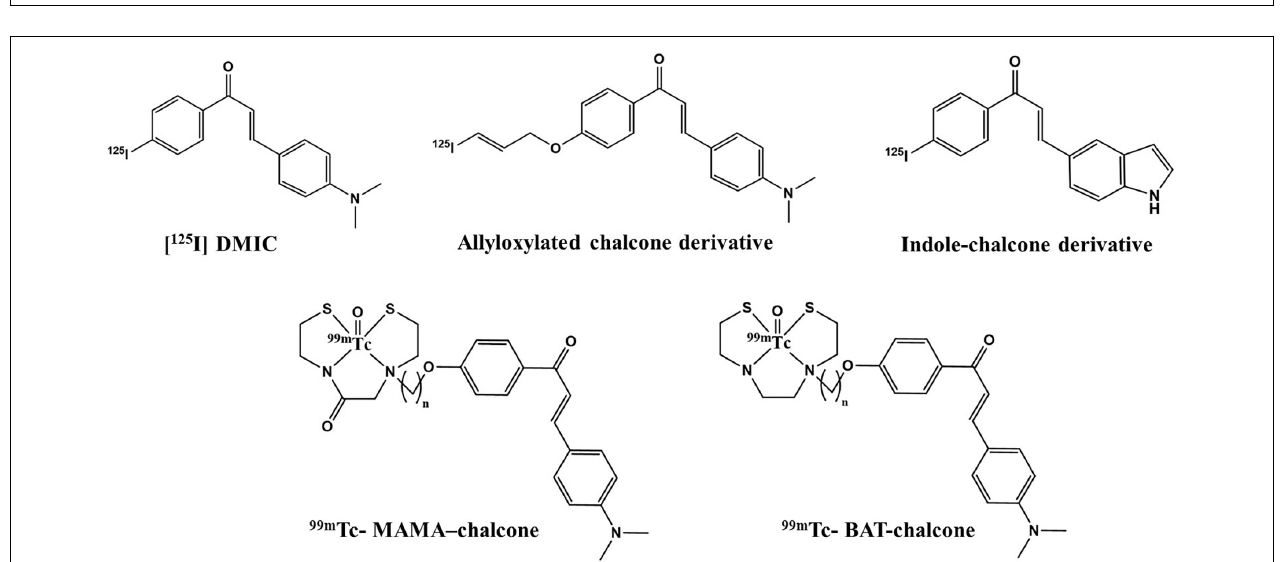
FIGURE 2 | Chalcone derivatives as A β 42 -specific single photon emission computed tomography (SPECT) imaging